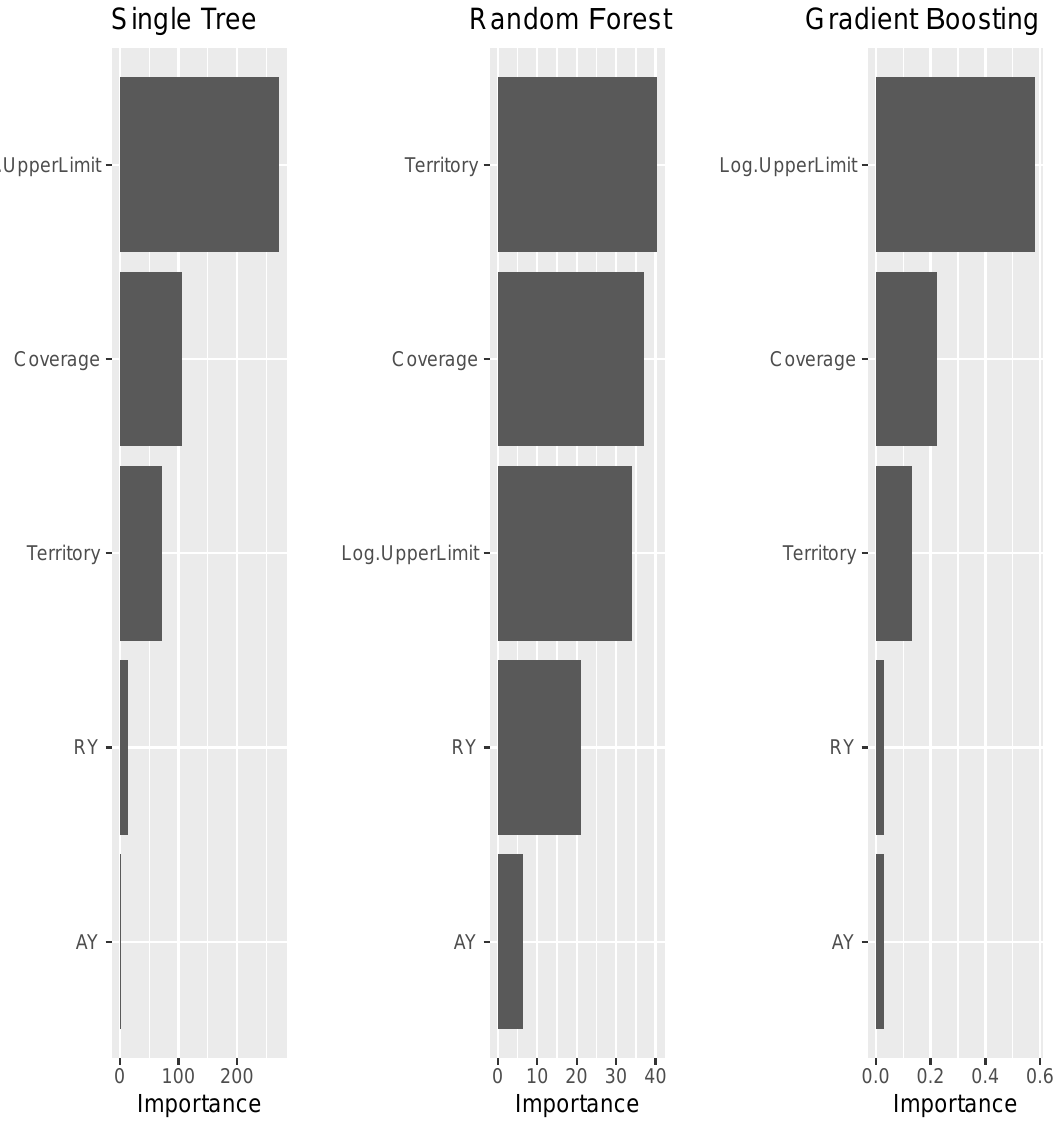
Figure 5. Variable importance measured by tree-based methods using log scale claim counts as model response